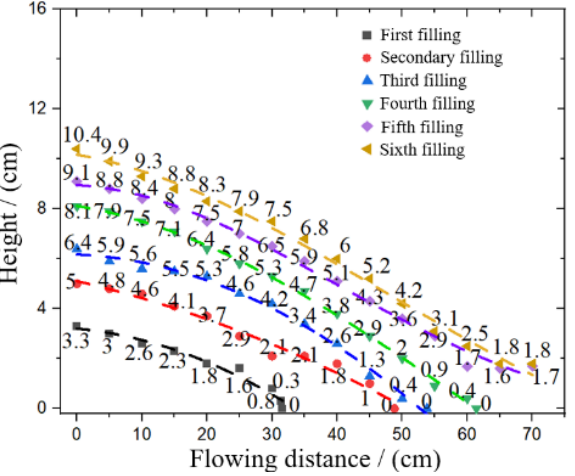
Figure 11. Flow accumulation slope fitting.